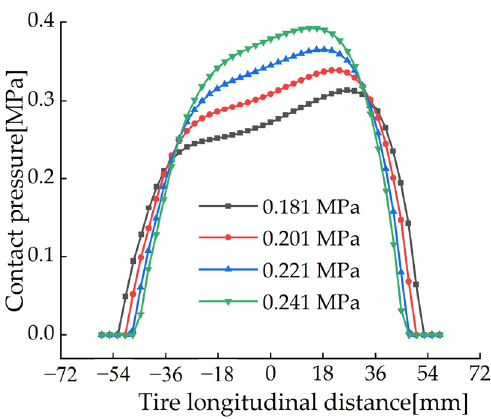
Figure 11. Contact pressure distribution of tire longitudinal contact patch under different inflation pressures.